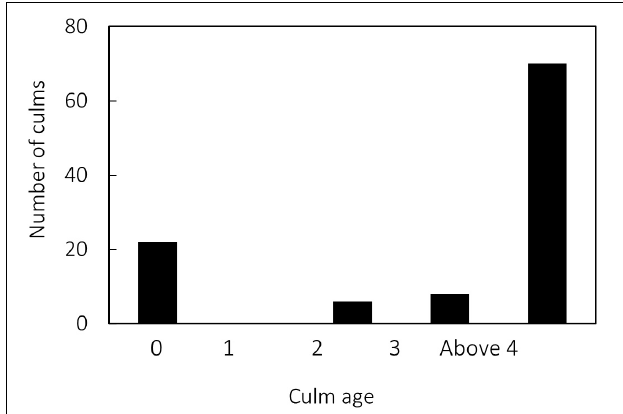
FIGURE 1 | Number of culms in each age group of bamboo at the study area. “0-year-old” culms correspond to culms that sprouted in April 2015, “current year culm”.